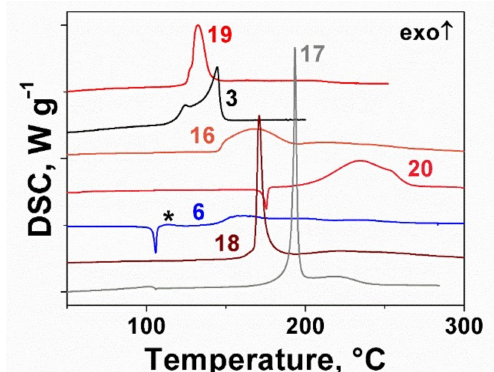
Figure 7. Thermal stability of the bicyclic furoxans 3 , 6 , and 16 – 20 . The di ff erential scanning calorimetry (DSC) curves were recorded at a heating rate of 5 K min − 1 . The star indicates a weak heat release due to a thermal isomerization of 6